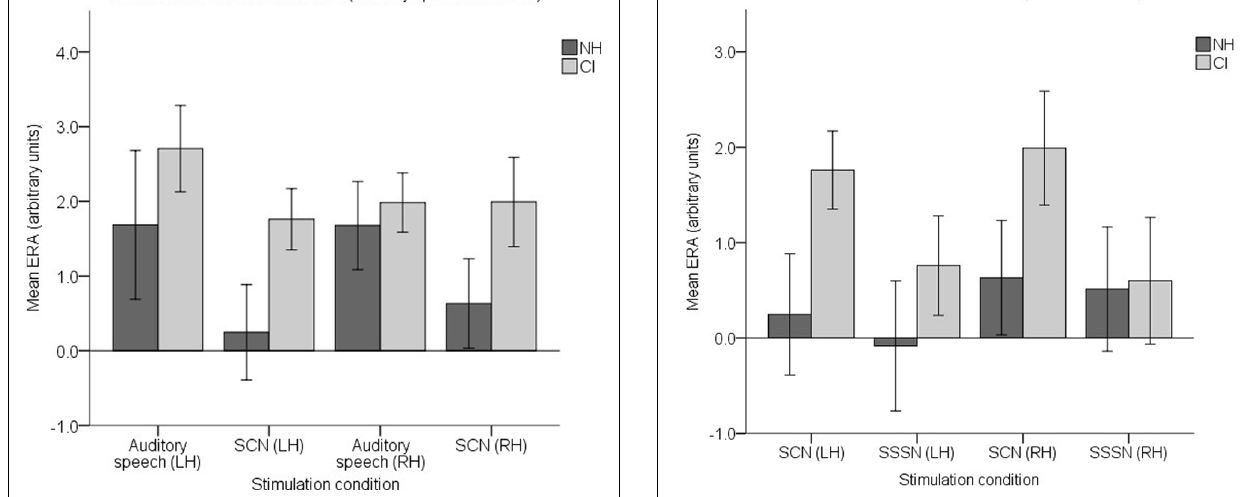
FIGURE 11 | Mean ERAs ( N = 39) derived from the ROI for the auditory speech and SCN conditions. Mean ERAs are shown for each group corresponding to channels 9, 10, and 12 in the LH and channels 20, 21, and 23 in the RH. Error bars show ± 1 standard error of the mean.